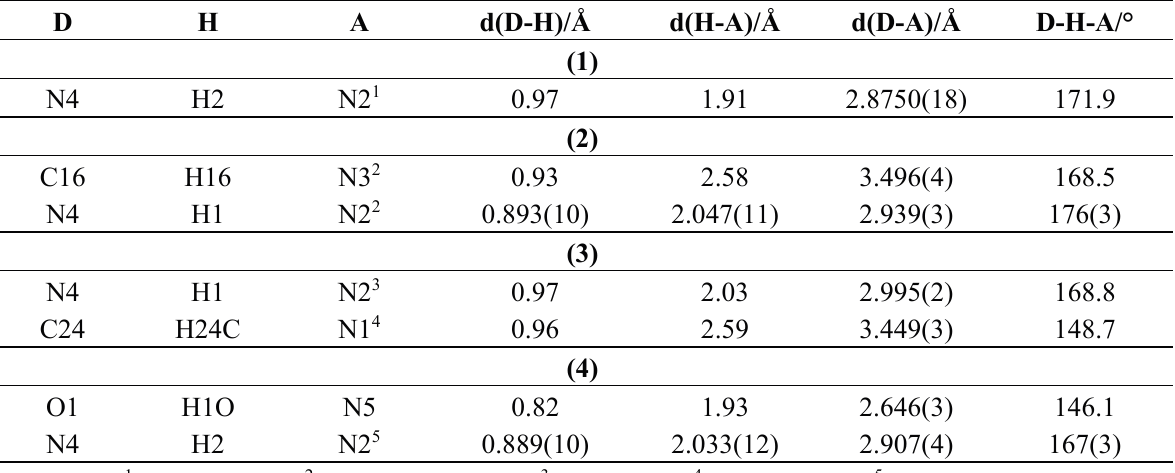
Figure 3. Unit cell diagrams of compounds 1 – 4 showing the inter- and intramolecular hydrogen bonding. Table 2. Hydrogen bond parameters of compounds 1 – 4